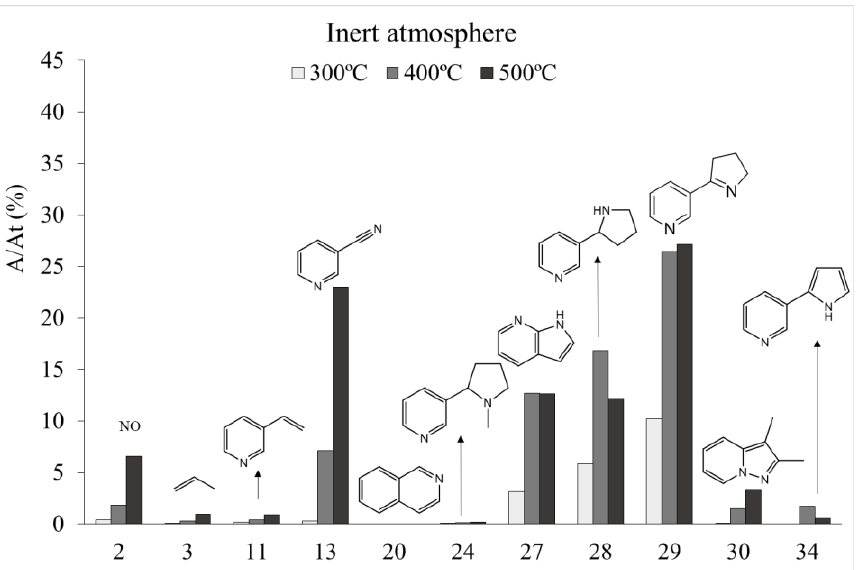
Figure 9. % area vs temperature of the majority compounds detected in the pyrolysis of NNN under inert atmosphere. Nitric oxide (2), 1-propene (3), 3-ethenyl-pyridine (11), 3-pyridinecarbonitrile (13), isoquinoline (20), nicotine (24), 1H-pyrrolo [2,3-b] pyridine (27), nornicotine (28), myosmine (29), 3,4-dimethyl-pyrrolo(1,2-a) pyrazine (30), nornicotiryne (34).